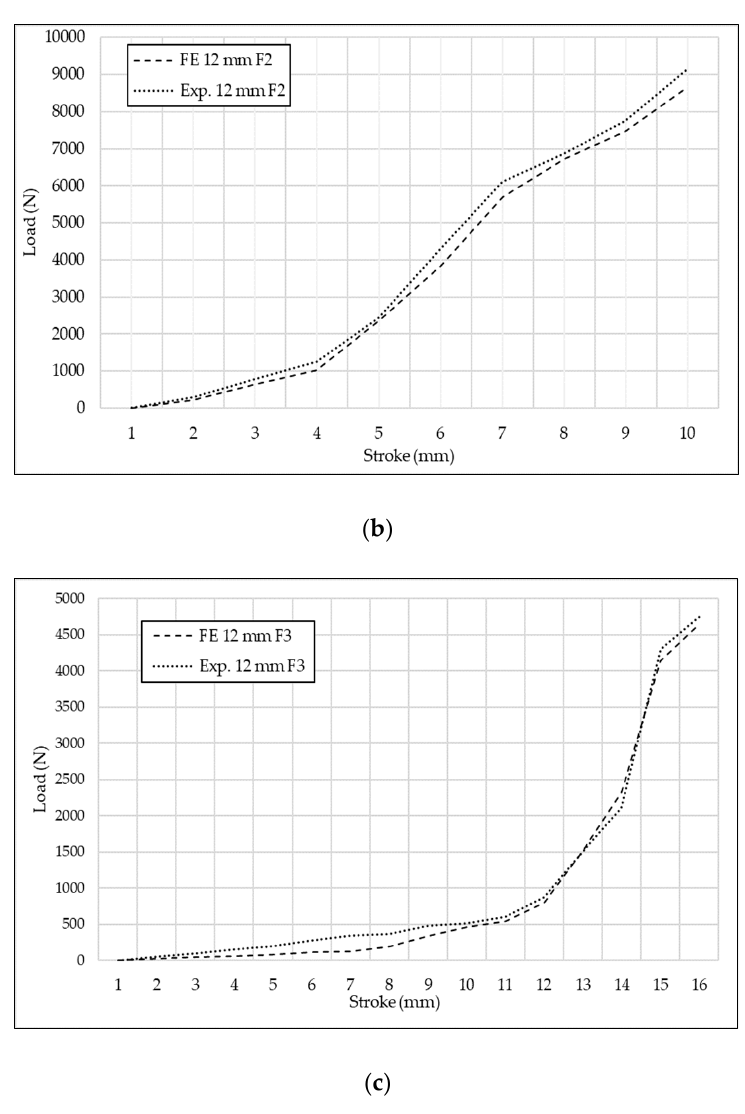
Figure 15. Comparison of load between simulations and experiments ( a ) form1; ( b ) form2; ( c ) form3.